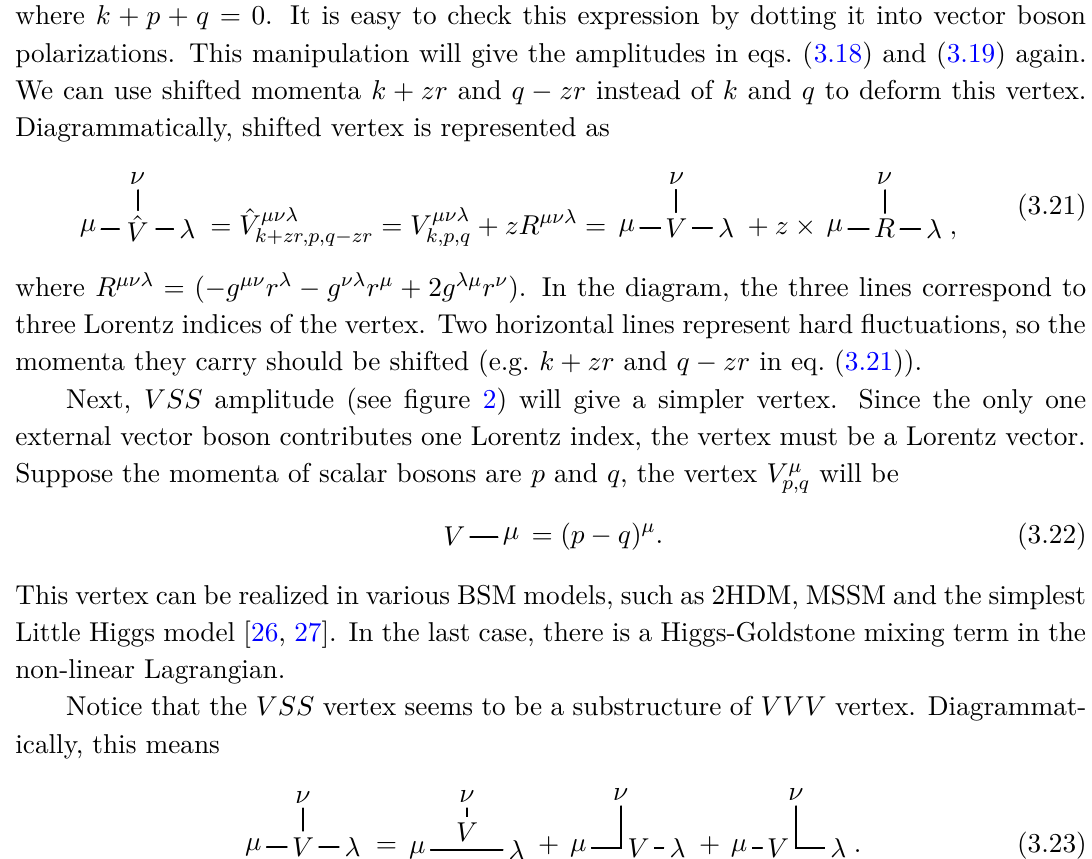
Figure 2 . V SS vertex with massive